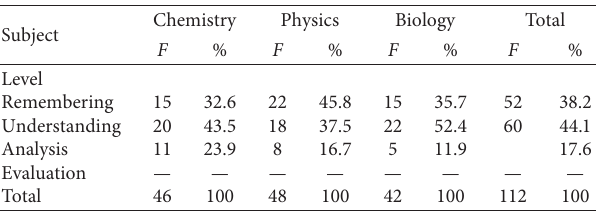
Table 4: Final examinations’ question distribution for chemistry, physics, and biology based on each level.